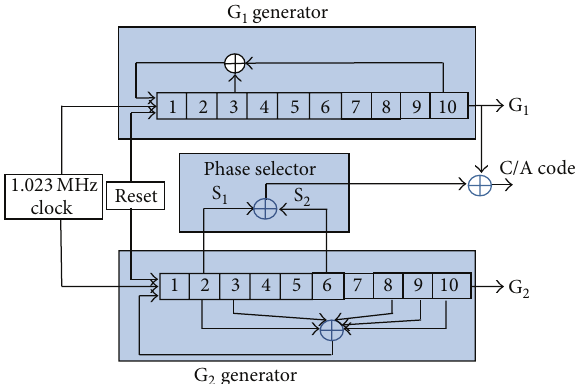
Figure 1: LSFRs based Gold codes